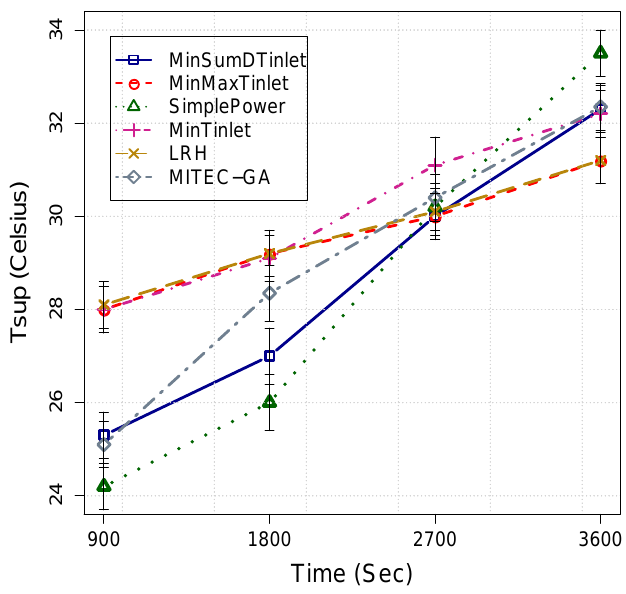
Figure 6. Supply temperature of different algorithms over time.